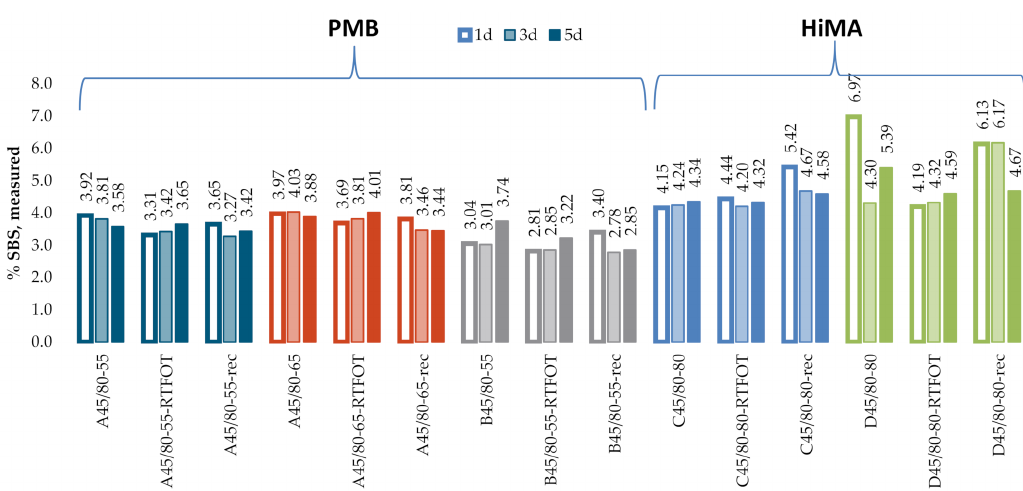
Figure 13. SBS contents in the samples of bitumen 50 / 70.